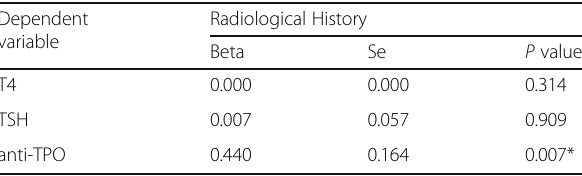
Note. All correlations significant at * p